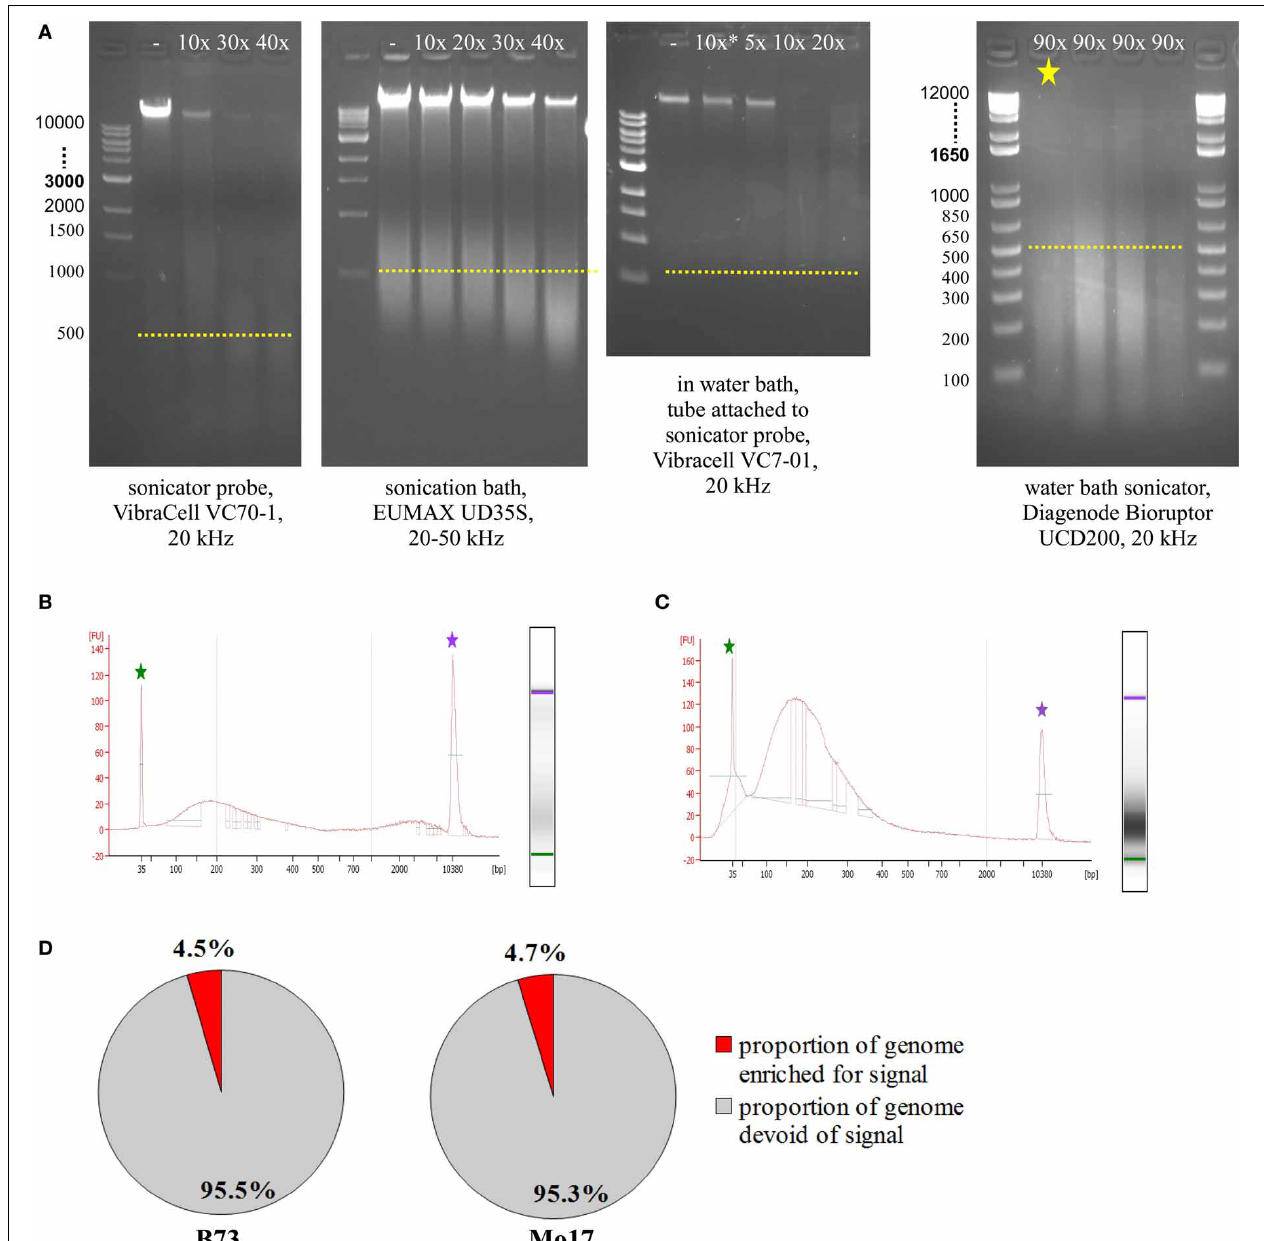
FIGURE 5 | Sonication optimization and ChIP enrichment. (A) Agarose gel electrophoresis of samples treated with different sonicators. (B) Agilent Bioanalyzer analysis of sample sonicated with the Bioruptor, Diagenode